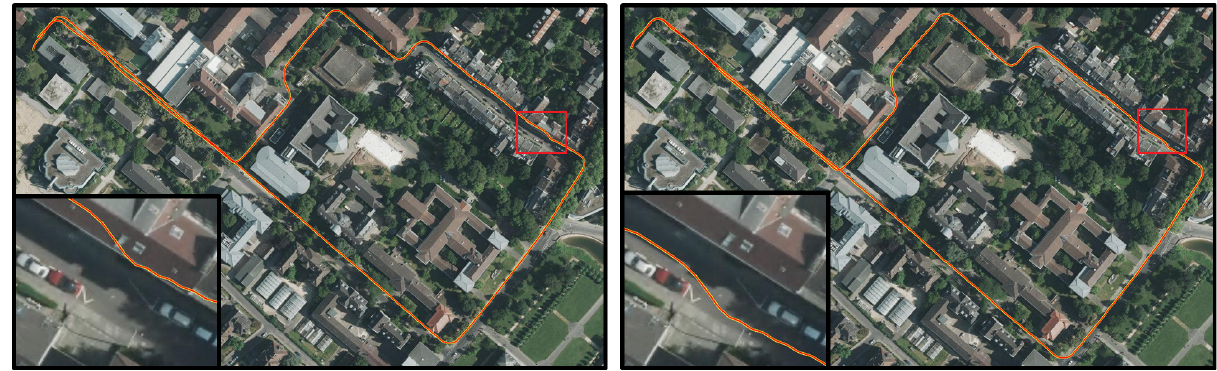
Figure 1. Trajectory recorded with a mobile mapping system in the university campus Poppelsodrf in Bonn/ Germany. The trajectory intersects with buildings (Left). The true trajectory corrected incorporating 3D city model of the surrounding area